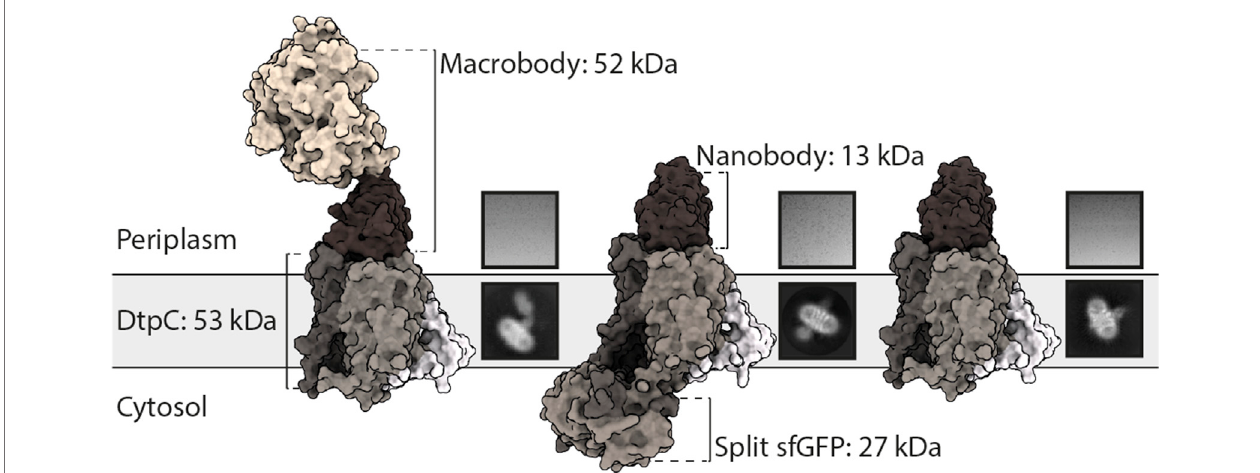
FIGURE 1 | Utilization of different fi ducial markers to improve particle alignment and 2D averaging from cryo-EM images. From left to right: DtpC-Mb26, split- sfGFP-DtpC 1-475 -Nb26, and DtpC-Nb26 were puri fi ed, vitri fi ed on grids and imaged. Single particles were identi fi ed, clustered and averaged. The best average from each sample is shown under a representative